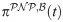
Representation of the configuration corresponding to the state variable πPNP,B(t).The arrows illustrate the meaning of the notation.